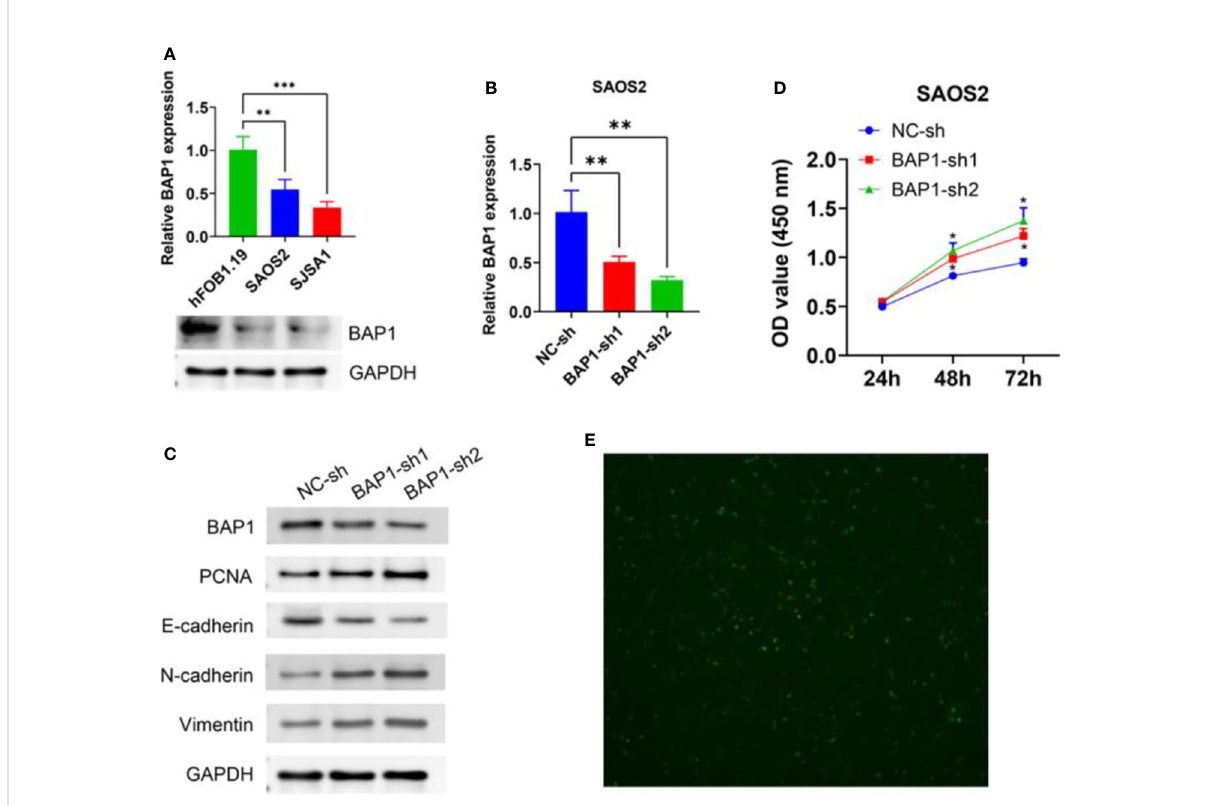
FIGURE 10 BAP1 knockdown promoted SAOS2 cells growth and EMT. (A) BAP1 expression in hFOB1.19, SAOS2, and SJSA1 cells detected by qPCR and western blot. (B) BAP1 expression after BAP1 knockdown detected by qPCR. (C) The protein expression of BAP1, PCNA, E-cadherin, N-cadherin, and Vimentin after BAP1 knockdown. (D) The viability of SAOS2 cells after BAP1 knockdown detected by CCK8. (E) Immuno fl uorescent image to detect BAP1 knockdown ef fi ciency in SAOS2 cells. **p < 0.01.